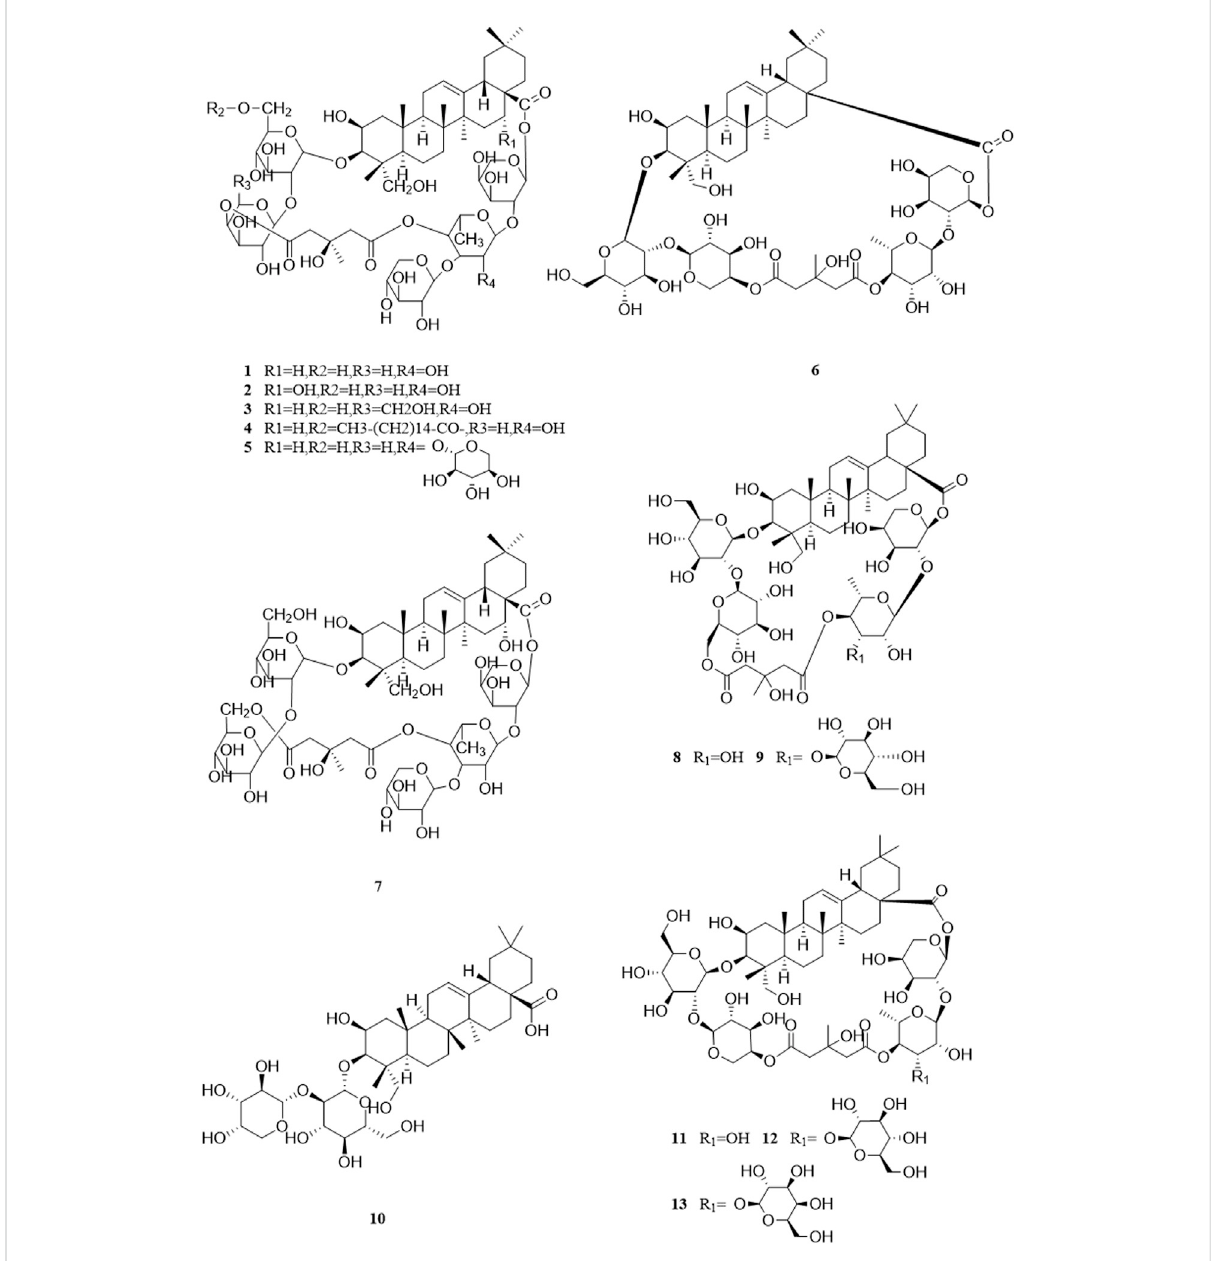
FIGURE 2 Structure of triterpenoids from Bolbostemma paniculatum (Maxim.) Franquet.